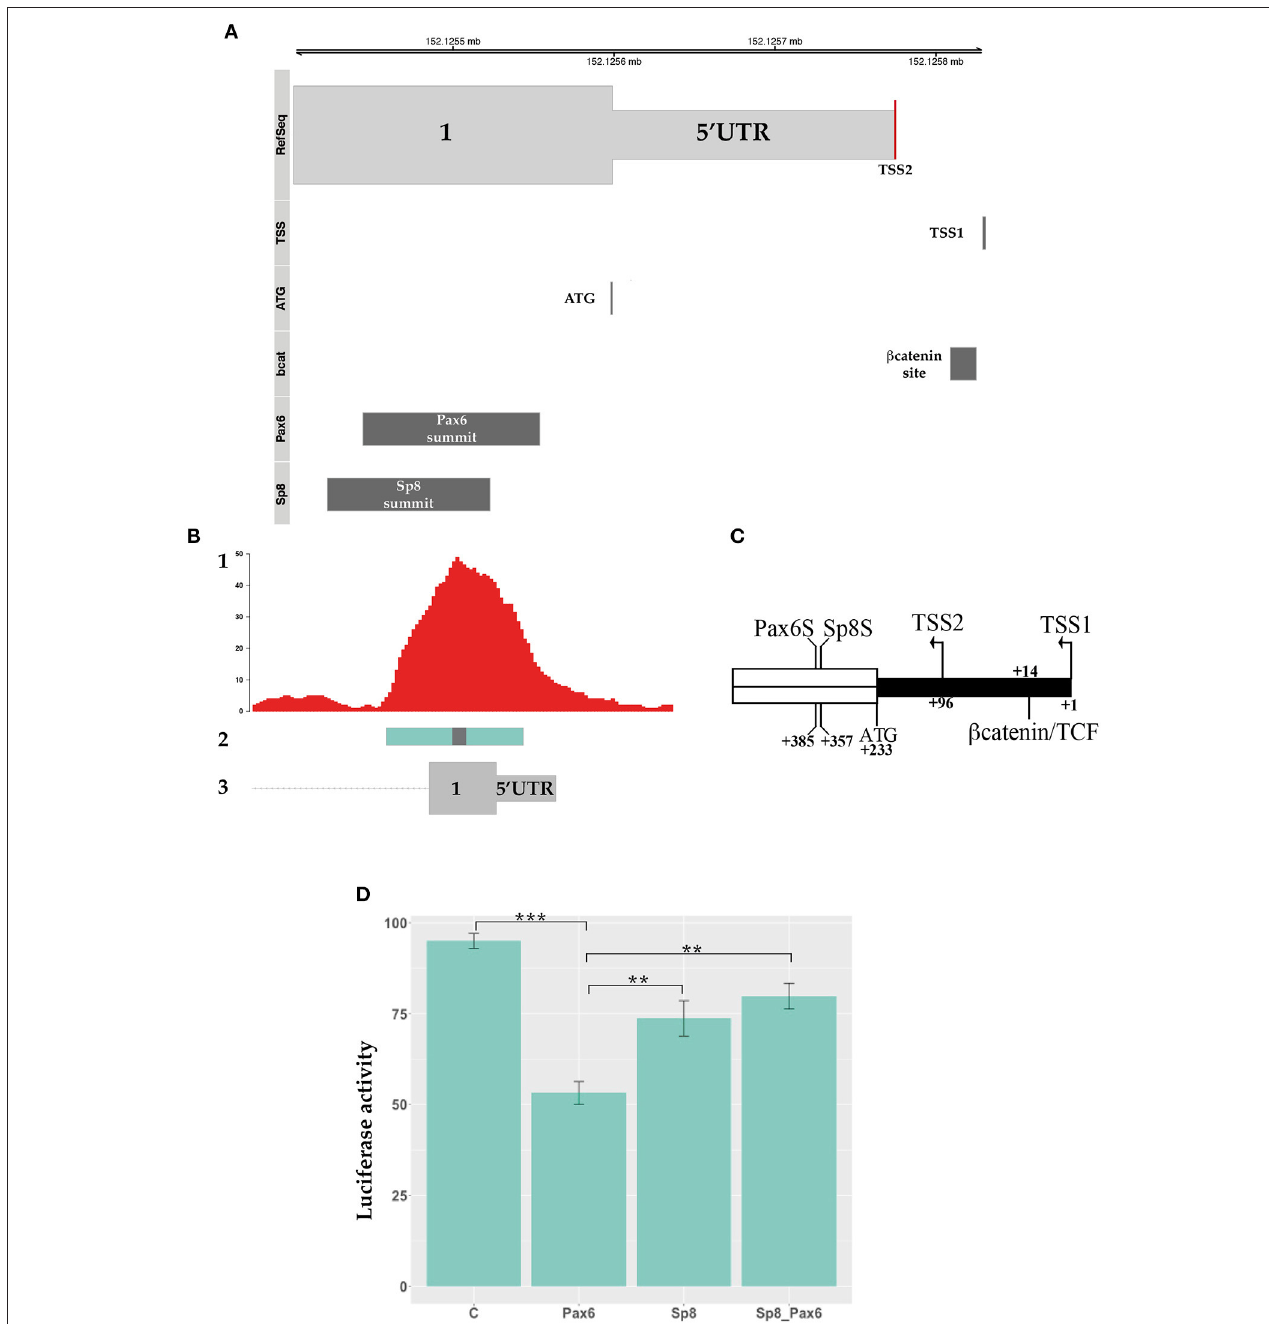
FIGURE 5 | PAX6 transcriptional regulation of Ccnd1 regulative regions. Panel (A) shows the schema of Ccnd1 locus. PAX6 [Chip peak fragment indicated in Sun et al. (2015)], SP8 (Chip peak summit ± 50 bp), β catenin binding sites, and the TSS (named TSS1) described in Eto (2000) are depicted together with Ccnd1 exon 1 first codon (ATG) and the TSS reported by the RefSeq gene model (TSS2, red line on the RefSeq track). Panel (B) represents the schema of the SP8 and PAX6 peaks positions on the Ccnd1 locus, showing the overlap between the SP8 (this work) and PAX6 ChipSeq peaks (Sun et al., 2015) on Ccnd1 Ex1 fragment. 1: SP8 Chip peaks, 2: PAX6 chipped fragment, 3: Ccnd1 RefSeq gene model. The gray box on the Pax6 fragment is the PAX6 binding summit shown in (A) . Panel (C) shows a schematic of β catenin, SP8 and PAX6 sites position on the 5 ′ portion of the exon 1 fragment. The PAX6 (PAX6S) and SP8 (SP8S) summit positions [indicated as the central nt of the Chip-qPCR fragment indicated in Sun et al. (2015) and the calculated ChipSeq summit respectively] are indicated. The TSS described in Eto (2000) (TSS1), the Ccnd1 first codon (ATG), and the TSS reported by the RefSeq gene model (TSS2) are also shown. The 5 ′ UTR is depicted in black. Panel (D) shows the luciferase assay results obtained from one representative experiment. Ccnd1 exon 1 was transfected in P19 cells alone or in combination with PAX6, SP8, and PAX6 together with SP8 (SP8_PAX6). Statistical significance, ANOVA: *** p < 0.001, ** p < 0.01.